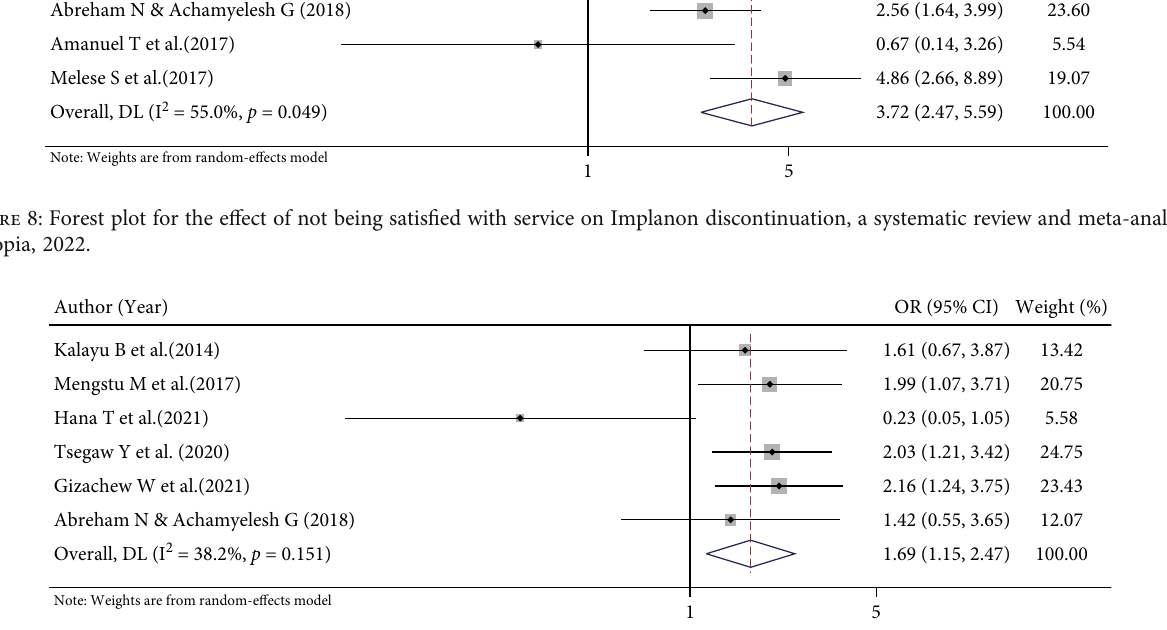
Figure 9: Forest plot for the pooled estimate of the e ff ect of not having a child on Implanon discontinuation, a systematic review and meta- analysis in, Ethiopia, 2022.